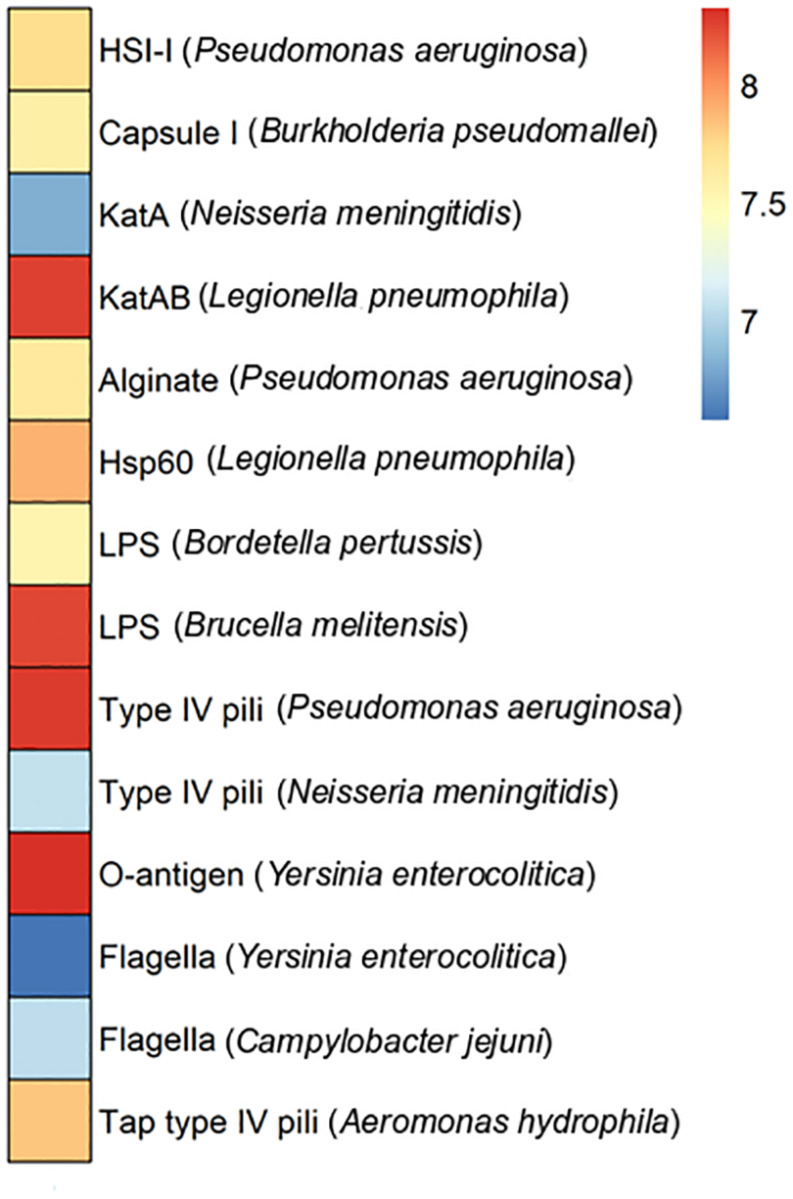
Virulence factors in the plasmidome of Puquio de Campo Naranja. The color scale indicates the abundance of each virulence factor in FPKM (fragments per kilobase per million). Values are plotted on a logarithmic scale. Pathogenic bacteria are specified in brackets.